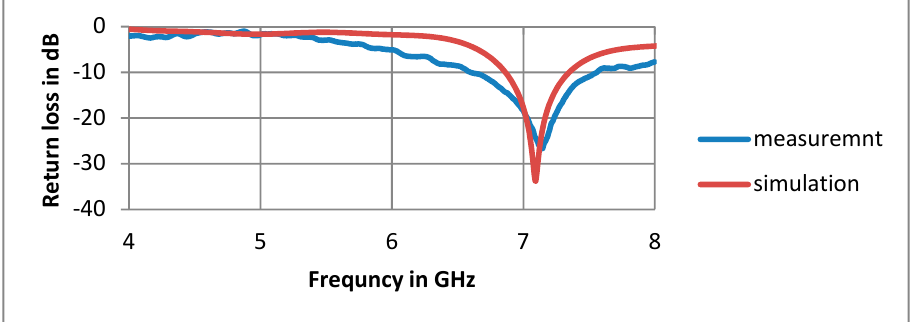
Figure 9. The simulated and measured return loss of antenna A with thickness of 0.508 mm.